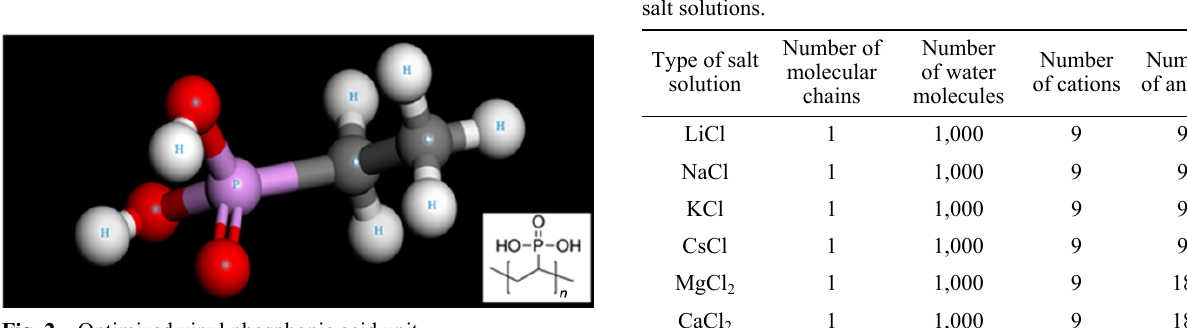
Fig. 2 Optimized vinyl phosphonic acid unit.